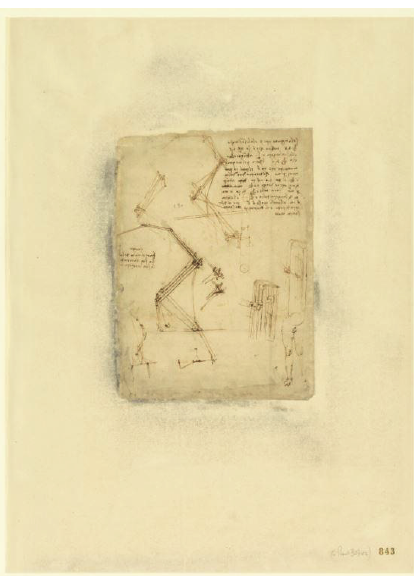
chloramphenicol (SAB) for the microfungi; Mannitol Salt Agar (MSA) for staphylococci. Petri dishes were incubated at 37 ∘ C for 48 hours to assess the microbial loads in TSA and MSA. SAB dishes were placed at 28 ∘ C for 7 days, and data were reported as Colony Forming Units (CFU)/m 2